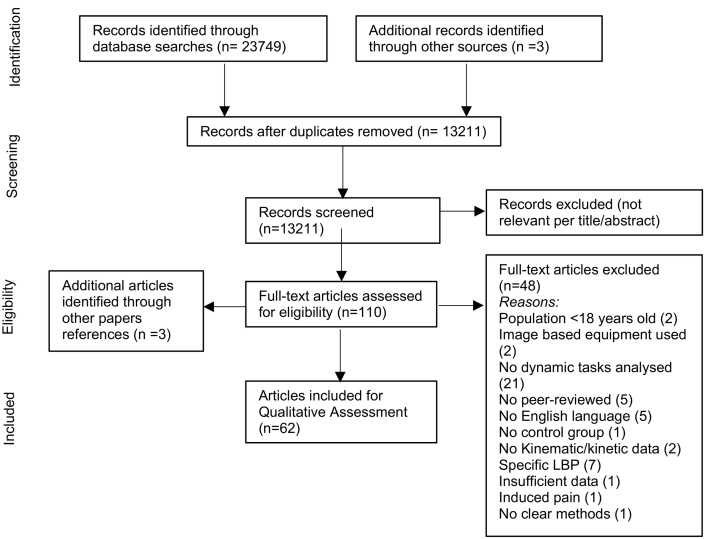
PRISMA flow diagram illustrating the review process (Moher et al., 2009).